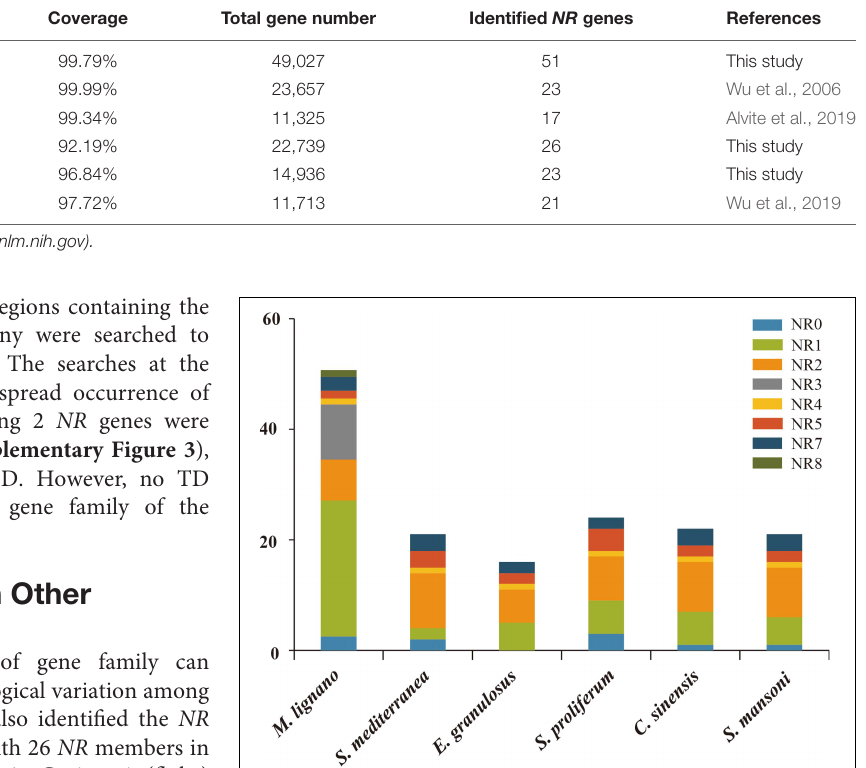
TABLE 1 | Genomic information and identified NR gene numbers in representative species of flatworms.